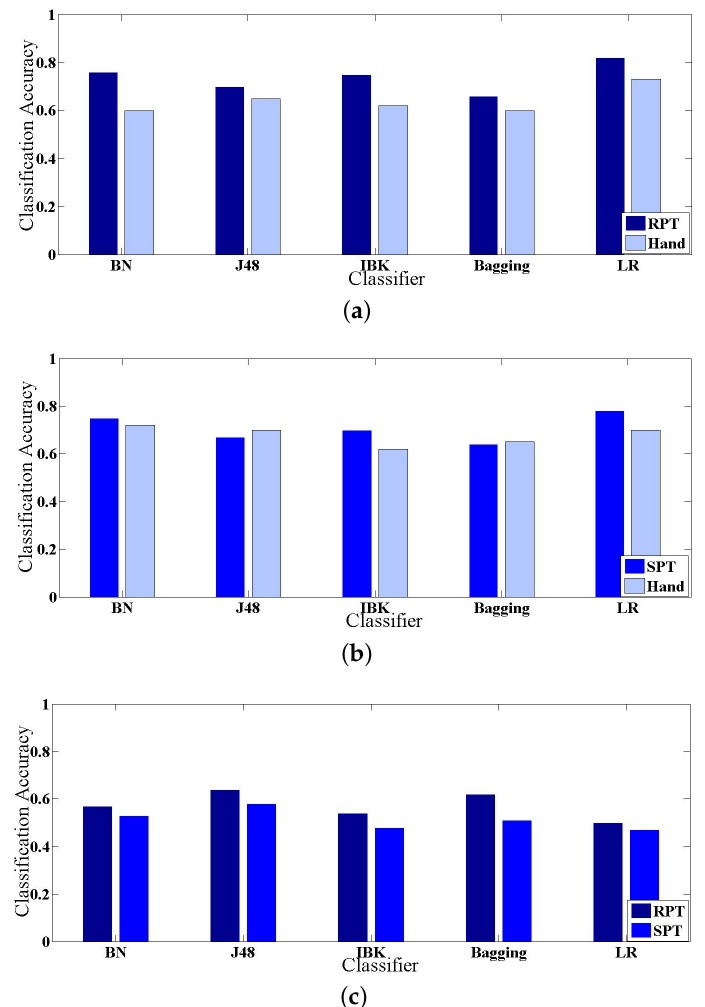
Figure 7. Classification accuracy for a device kept in different position (SPT, RPT and Hand) ( a ) for training position SPT; ( b ) for training position RPT; ( c ) for training position Hand.